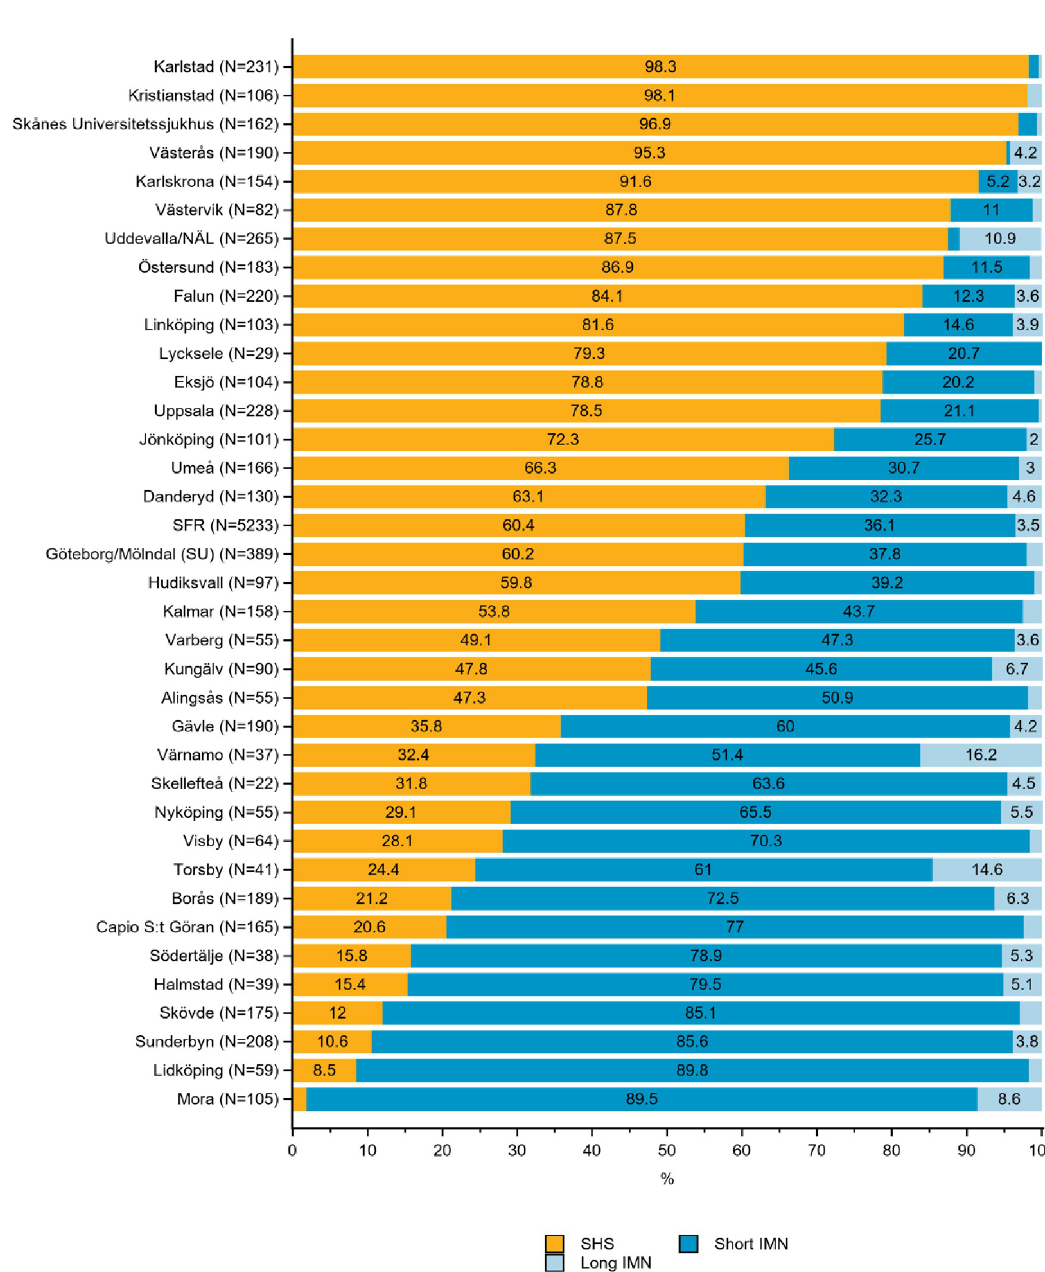
Fig 2. Distribution of sliding hip screw (SHS), short and long intramedullary nail (IMN) in the treatment of A1 trochanteric hip fractures by department in the Swedish Fracture Register in 2016–2020. SFR denotes all registrations in the Swedish Fracture Register (distributions are nationwide